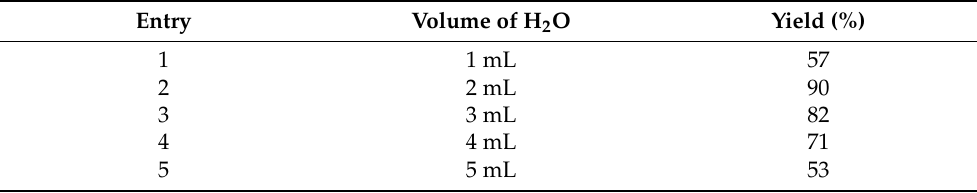
Table 2. Investigating the effect of water on the optimized Passerini